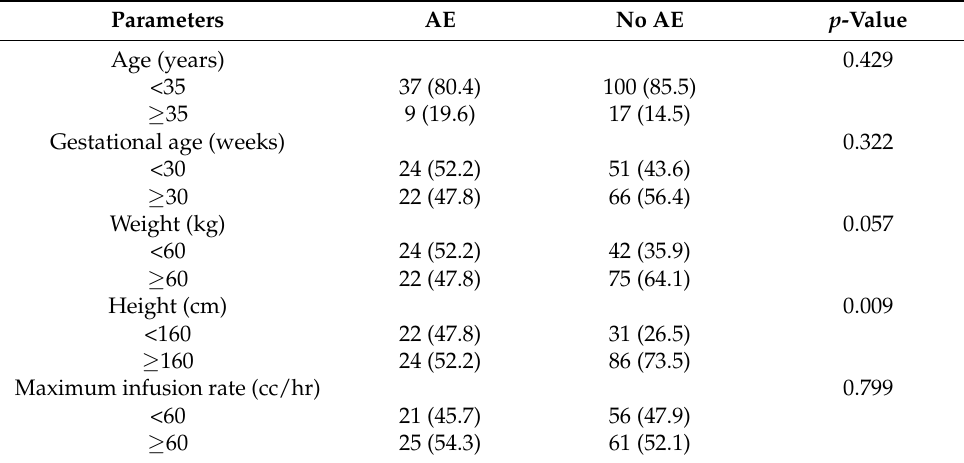
Table 1. Effects of demographic characteristics on ritodrine-induced adverse